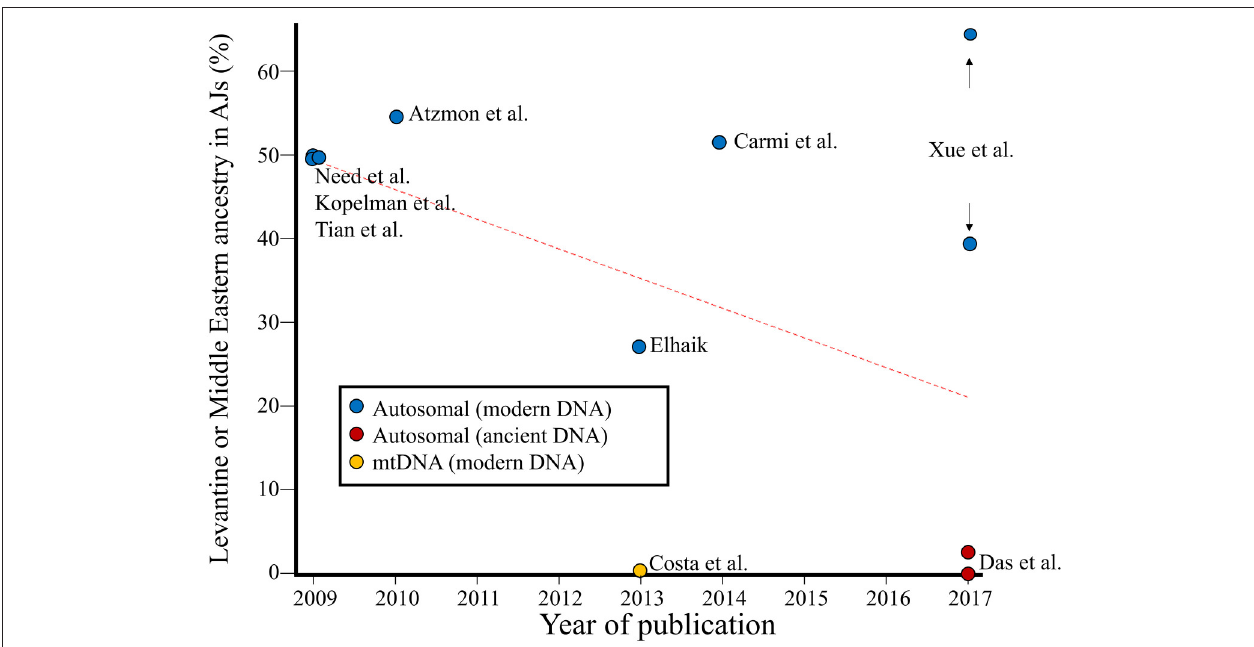
FIGURE 1 | The Levantine or Middle Eastern ancestry of Ashkenazic Jews over time. Nine genomic estimates of the Levantine ancestry in AJs (2009–2017) (Kopelman et al., 2009; Need et al., 2009; Tian et al., 2009; Atzmon et al., 2010; Costa et al., 2013; Elhaik, 2013; Carmi et al., 2014; Das et al., 2016; Xue et al., 2017) derived from autosomal, whole genome, or mtDNA data are shown. Studies reporting “intermediate” percentage between Middle Eastern and European populations are shown as 50% Middle Eastern ancestry. The percentage of Levantine ancestry among AJs shows a decreasing trend over time ( r = − 0.49) with the most recent estimates being close to